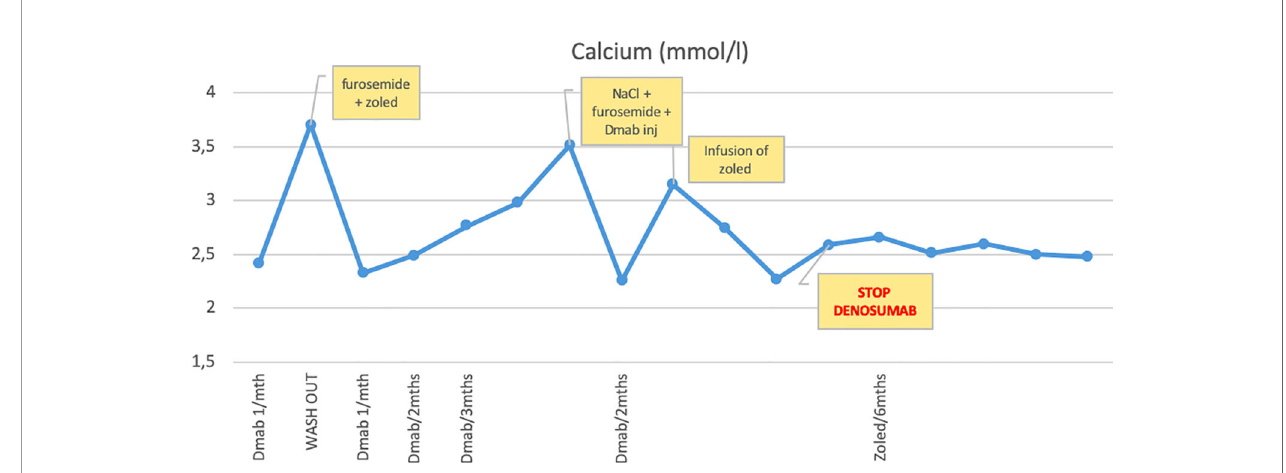
FIGURE 2 | Trend of serum calcium levels during denosumab therapy. Hypercalcemia occurring during wash-out period, progressive rise of serum calcium levels when the injections are spaced and calcium levels remained below the upper limit of normal with 6 monthly IV zoledronic acid infusions.